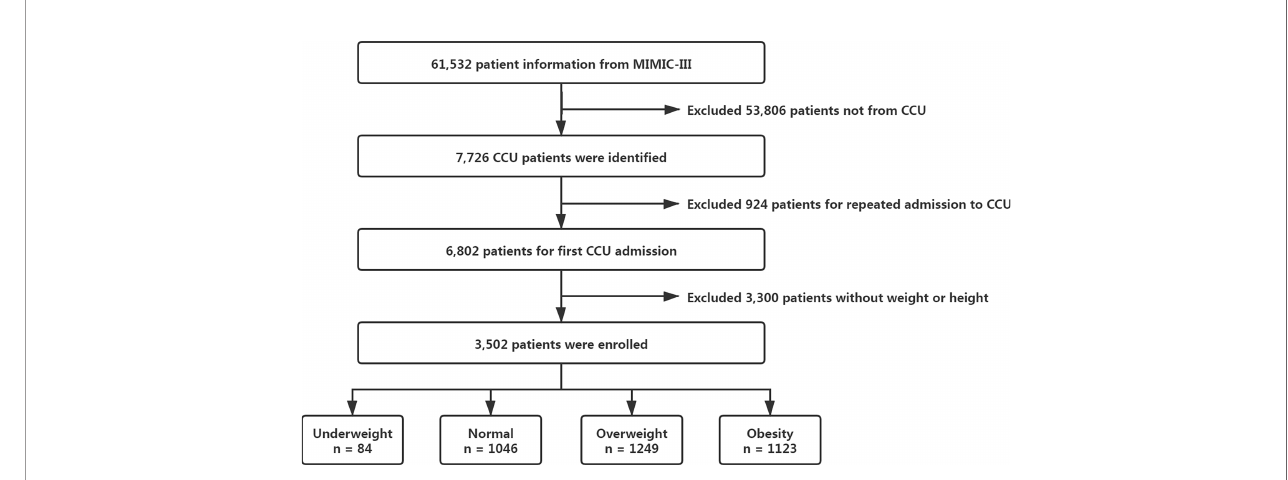
FIGURE 1 | Flowchart of the